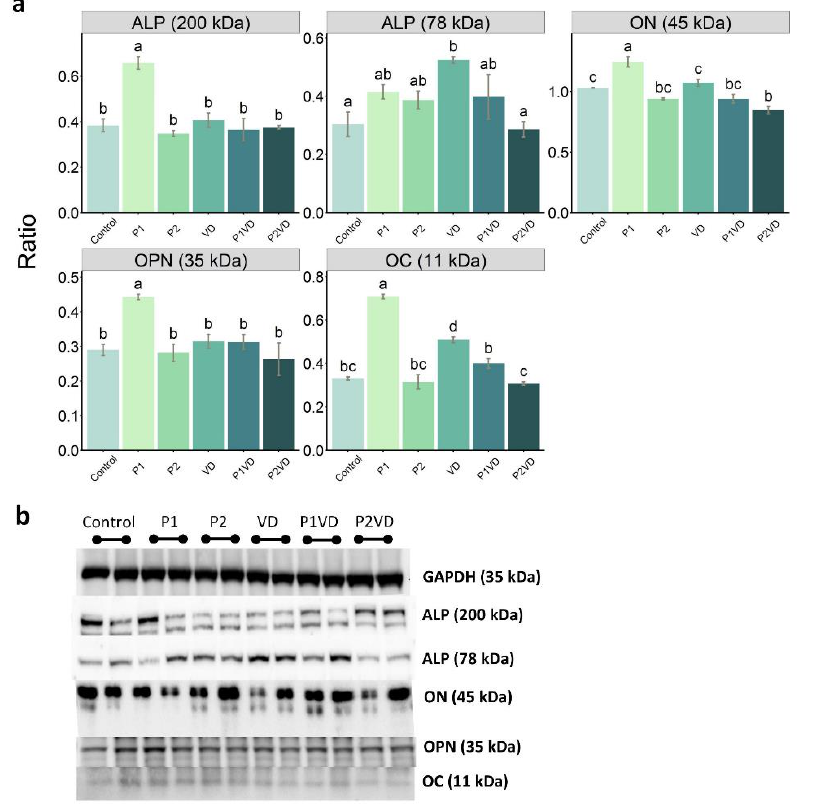
Figure 3. WB analysis of the expression of bone formation related proteins: ALP (200 and 78 kDa), ON, OPN, and OC in hFOB1.19 cells cultured without any treatment (Control), treated with VD (VD), with two probiotics (P1 and P2) and their respective combinations with VD (P1VD and P2VD): ( a ) Relative expression of the proteins calculated as a ratio of band density with respect to glyceraldehyde 3-phosphate dehydrogenase (GAPDH). One-way ANOVA was used to compare between groups and Tukey’s post hoc test was used for multiple comparisons among all the groups. Data are shown as means ± SD as error bars. Different letters above each column denote statistically significant differences among experimental groups ( n = 2, p < 0.05). Three groups that differ significantly from each other are labelled a, b, and c, and two that differ from each other but not from the third are labelled a, b, and ab; ( b ) Representative WBs ( n = 4) visualized by enhanced chemiluminescence method for GAPDH, ALP (200 and 78 kDa), ON, OPN, and OC proteins.